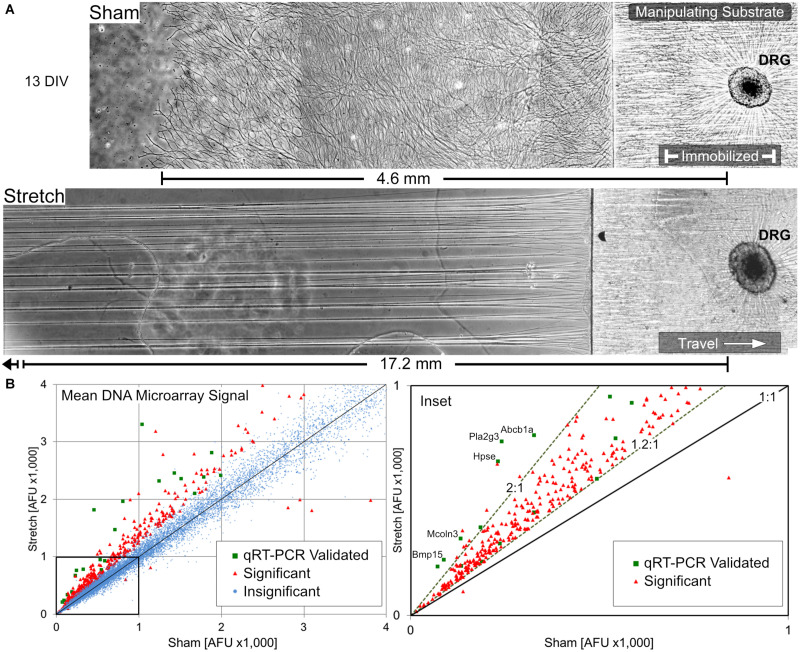
Overview of stretch-growth and DNA microarray results in DRG neurons. (A) Representative growth of individual sham and stretch-grown explants after 13 days in vitro prior to RNA isolation, see Figure A2 for full panorama. (B) Whole-transcriptome analysis with Affymetrix GeneChip Rat Gene DNA Microarrays revealed broad upregulation in stretch-grown DRG. Significant fold-changes were determined by a normalized average microarray fluorescence ratio ≥+1.2:1 or ≤–1.2:1 in stretch-grown cultures relative to sham. Quantitative RT-PCR was used to validate gene expression across the fluorescence spectra of microarray results.